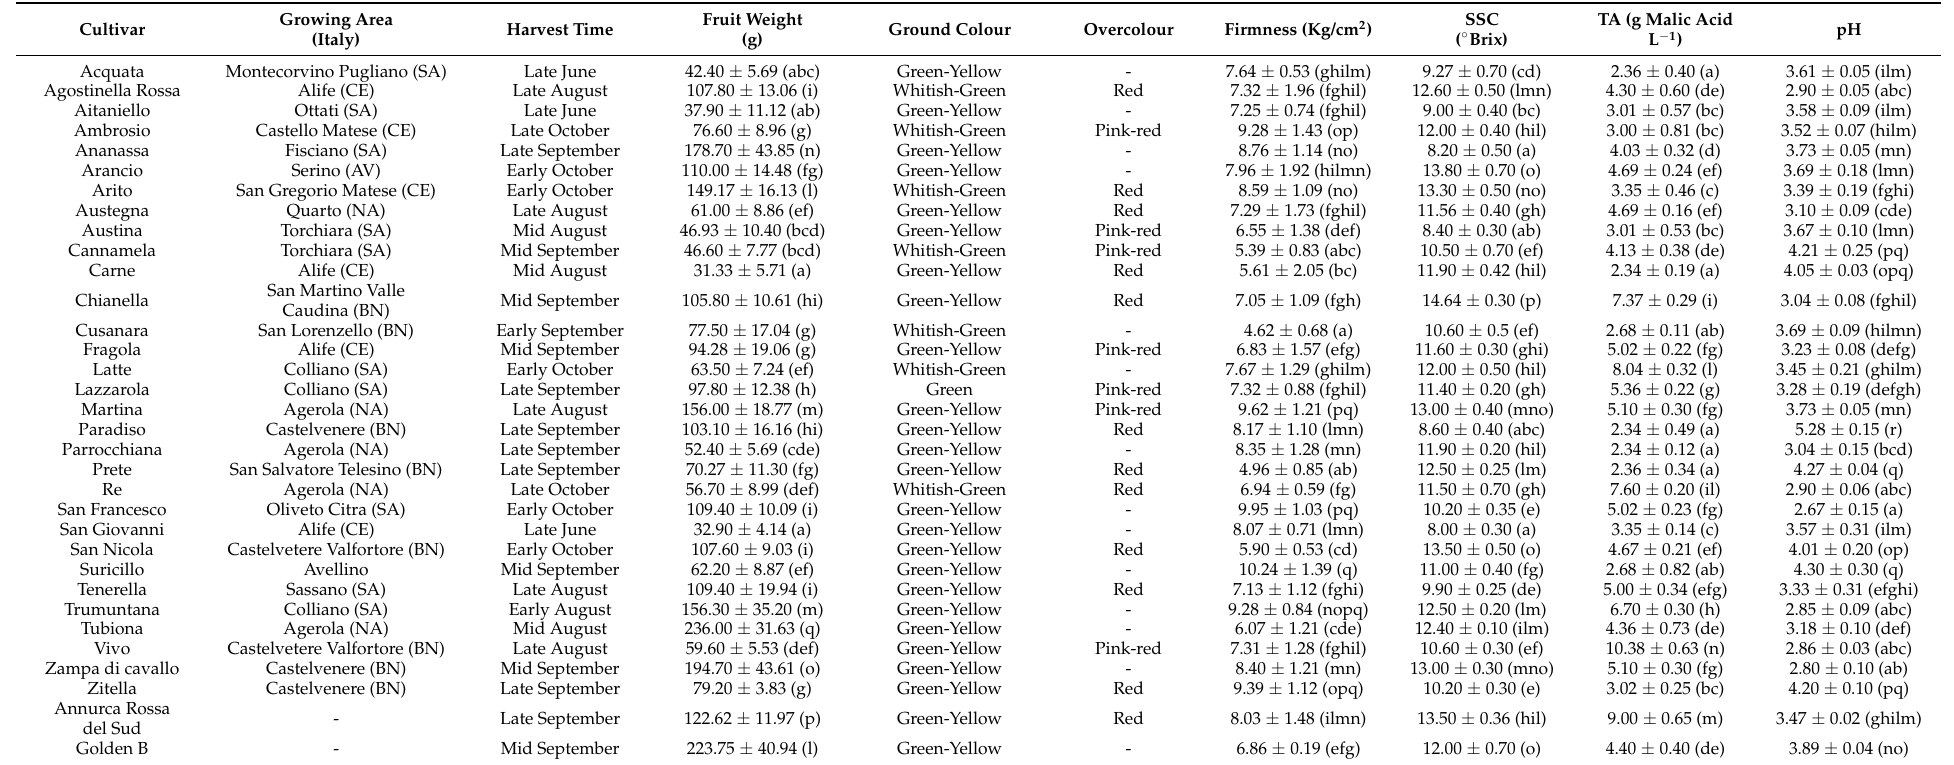
Values in a column with a common letter are not significantly different, p < 0.05 (Duncan